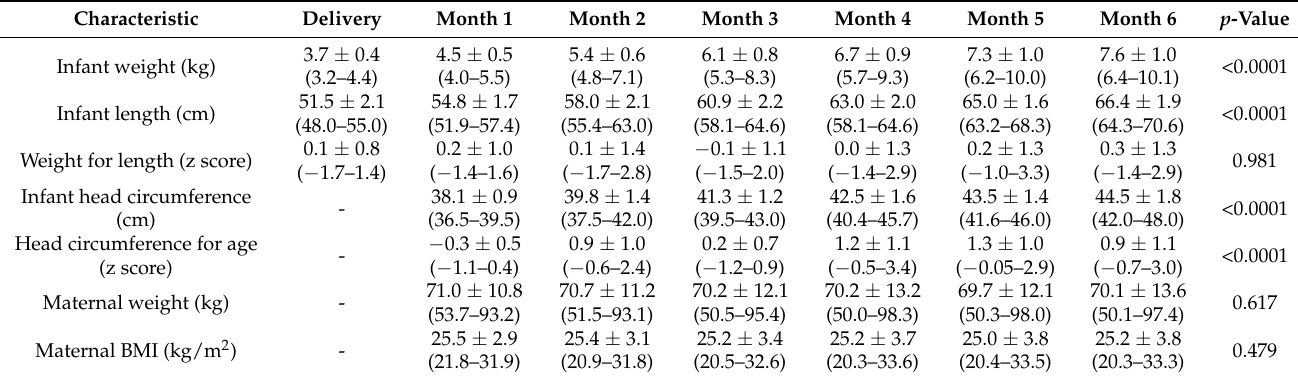
Table 1. Measured and calculated cohort characteristics from infants of birth to six months of